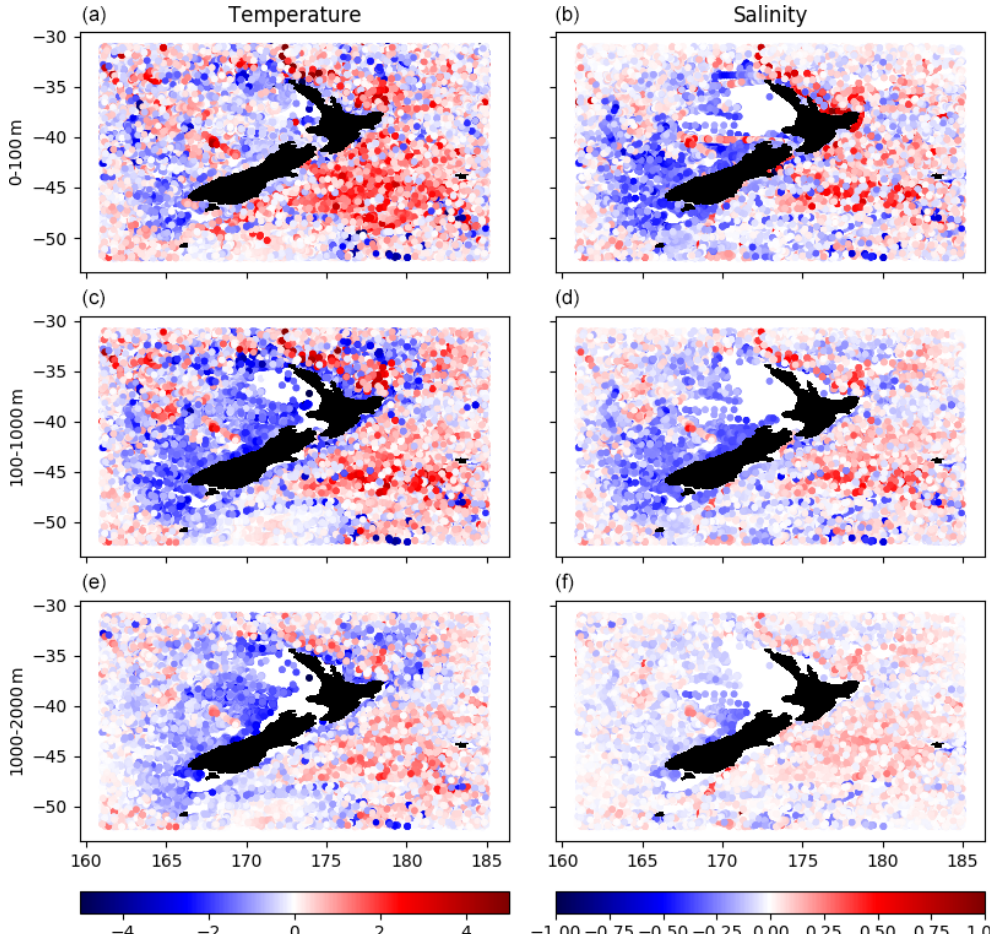
Figure 8. Scatter map of the depth mean deviation (by layers) of the Moana Ocean Hindcast results from the CORA5.2 temperature ( ◦ C; a, c, e ) and salinity (gkg − 1 ; b, d, f ) observations. The differences are divided by slabs corresponding roughly to the mixed layer (0–100m; a, b ), thermocline (100–1000m; c, d ) and deep waters (1000–2000m; e, f ). A geographic distribution pattern is evident in the model result differences, which follow the same overall distribution presented by the GLORYS